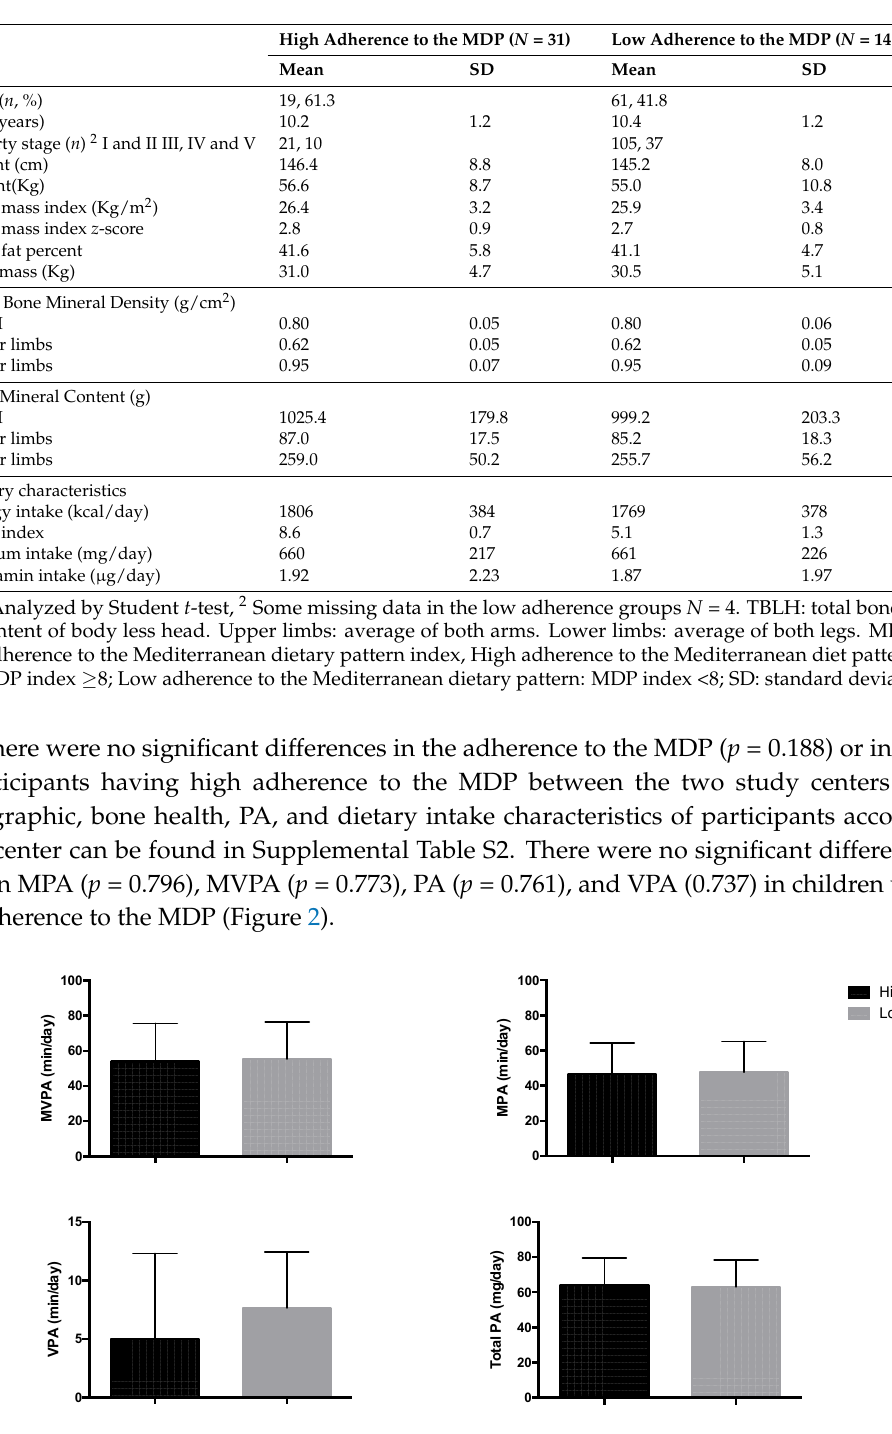
Table 1. Characteristics of participants according to their adherence to the Mediterranean dietary pattern (MDP).